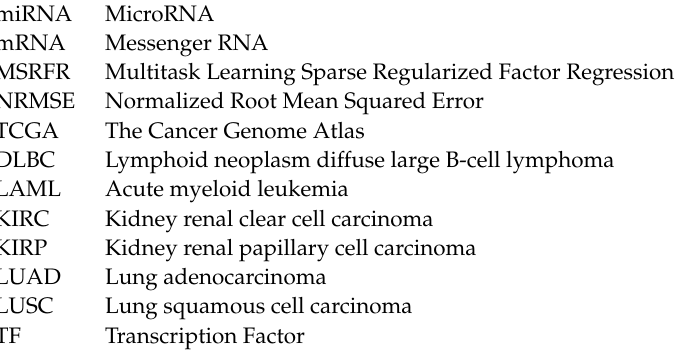
tary Table S2: Supporting evidence for cohort-specific identified miRNAs, Supplementary Table S3: Supporting evidence for importance of interaction between identified miRNAs and mRNAs, Supple- mentary Table S4: Verification of identified